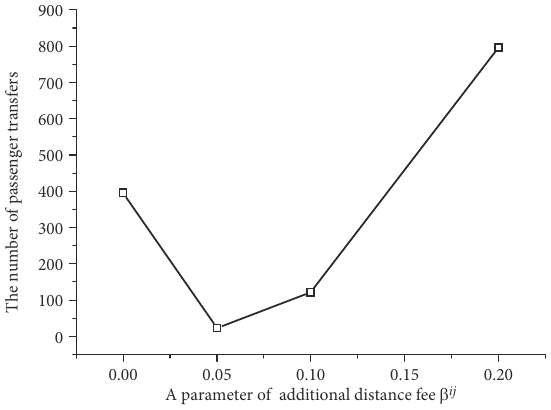
Figure 9. The number of passenger transfers for different values of β